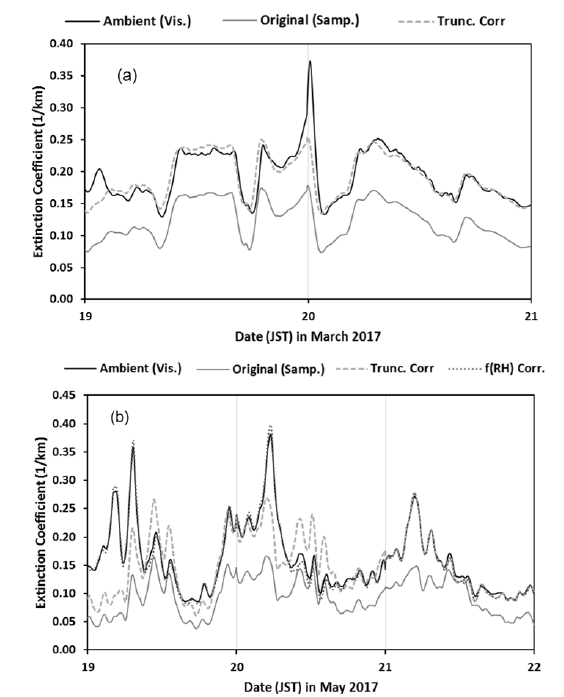
Fig. 1 Temporal change of AEC observed under a relatively (a) low RH and (b) high RH conditions. In (b), both the truncation and f ( RH ) corrections are applied to the value from the sampling measurement.